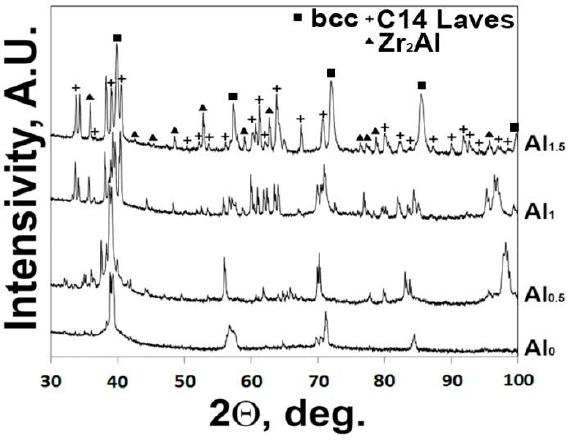
Figure 1. XRD patterns of the Al x NbTiVZr ( x = 0; 0.5; 1; 1.5) alloys after annealing at 1200 °C for 24 h.